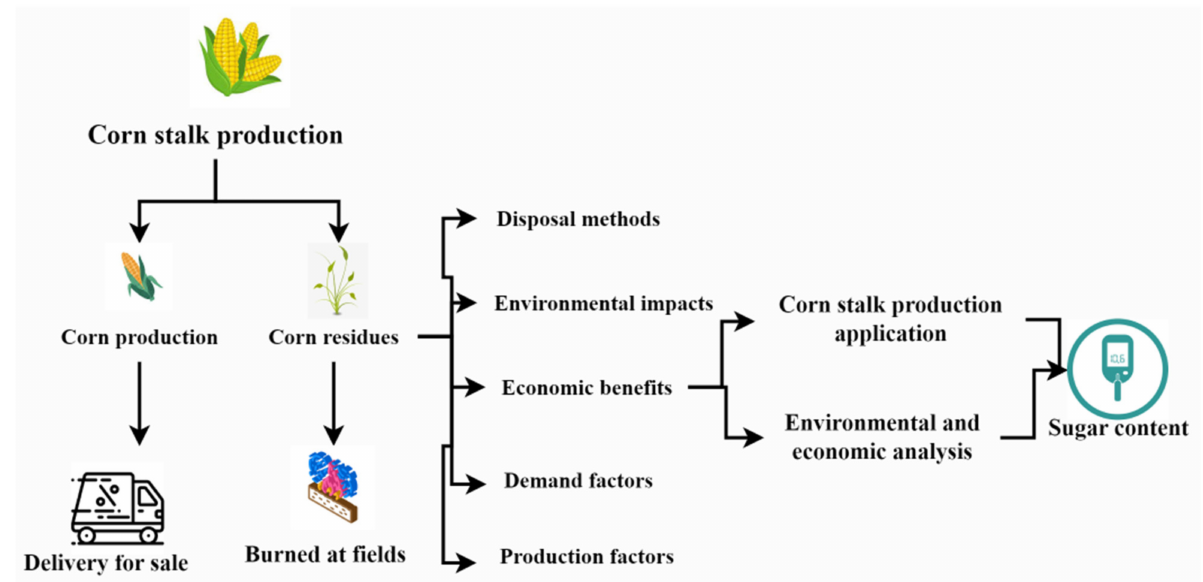
Figure 1. Sugar content in corn